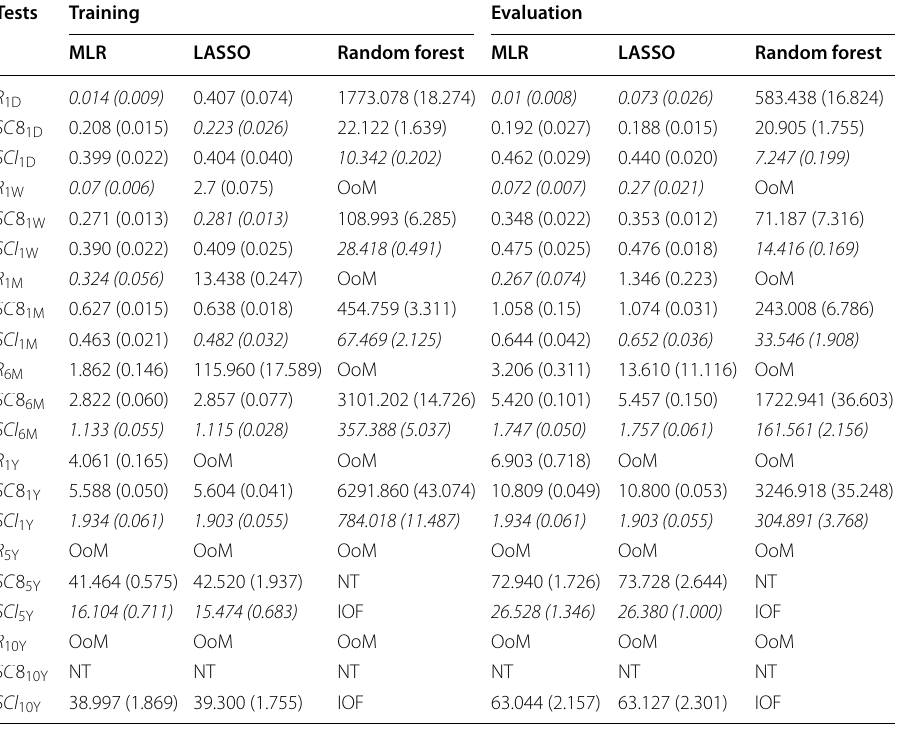
The values in parenthesis are the standard deviation values Italics : lowest computation time for a given data mining technique and a certain amount of training/evaluation data OoM out of memory, NT not tested, IOF integer